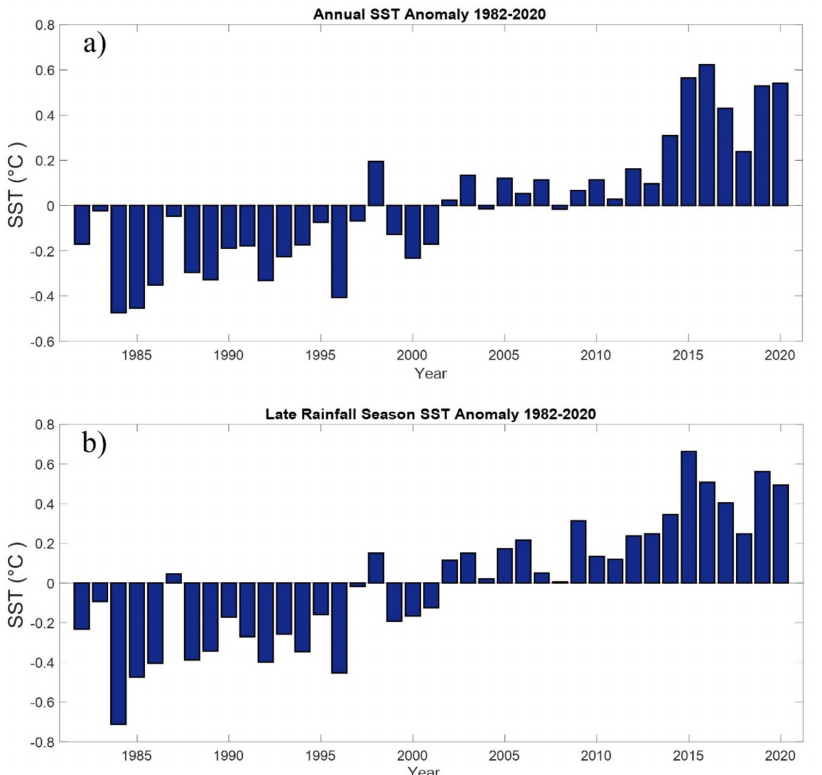
Figure 3. Caribbean and surrounding region sea surface temperature anomalies observation: ( a